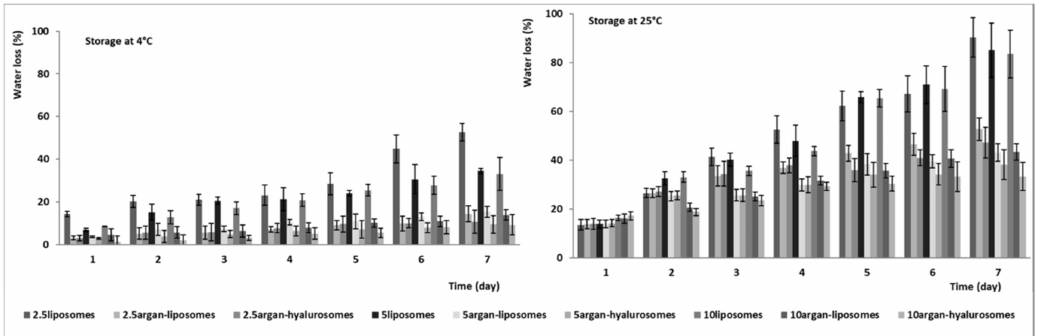
Figure 4. Amount of water loss (%) from liposomes, argan-liposomes and argan-hyalurosomes over 7 days of storage at 4 ◦ C and 25 ◦ C. Mean values ± standard deviations (error bars) have been